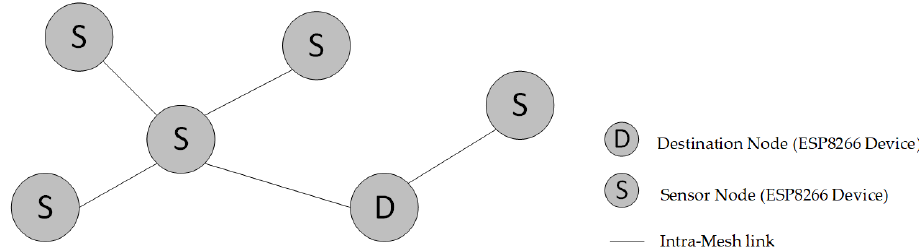
Figure 1. Example of a painlessMesh